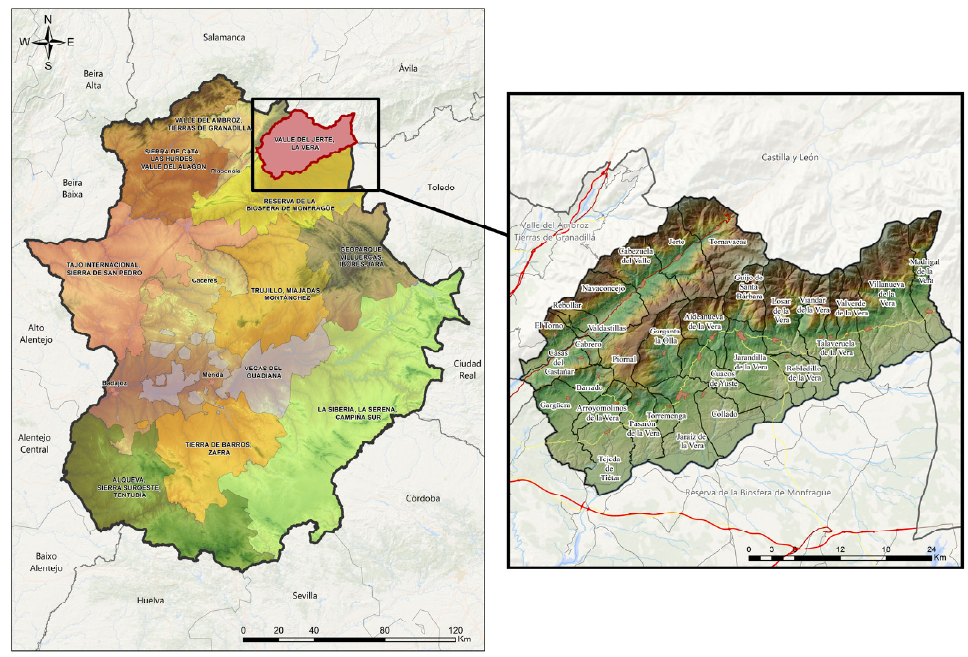
Figure 1. Map showing the location of the tourist territory of Valle del Jerte-La Vera.